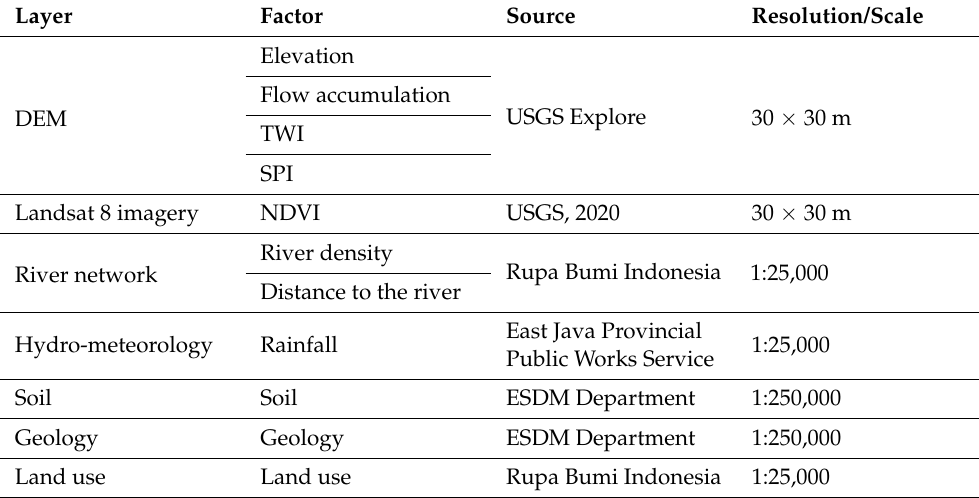
Table 1. Flood conditioning factors